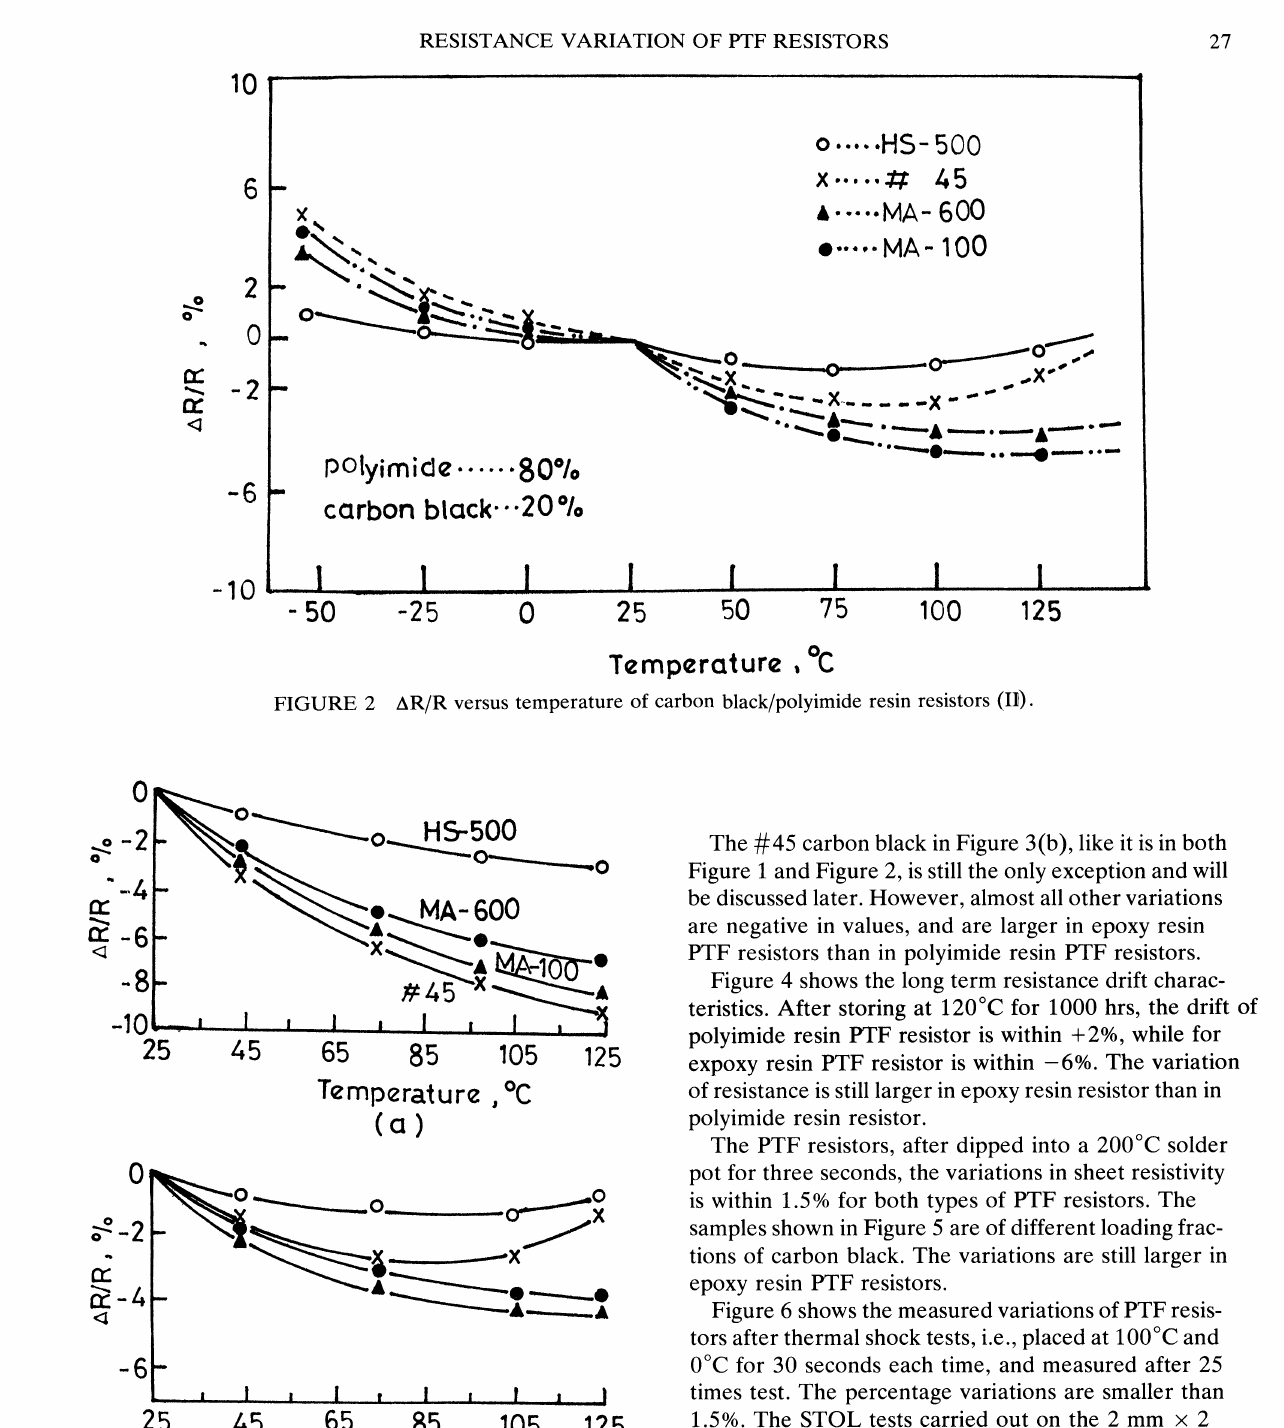
FIGURE 3 AR/R versus temperature of (a) carbon black/ epoxy resin, (b) carbon black/polyimide resin PTF